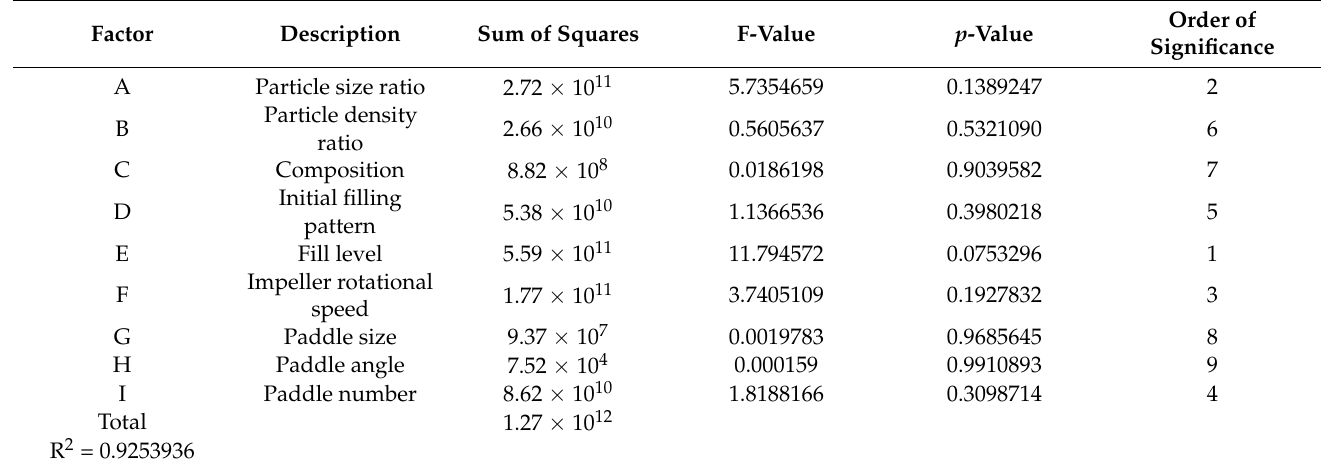
Table 9. Analysis of variance (ANOVA) results of KPI 4 total energy